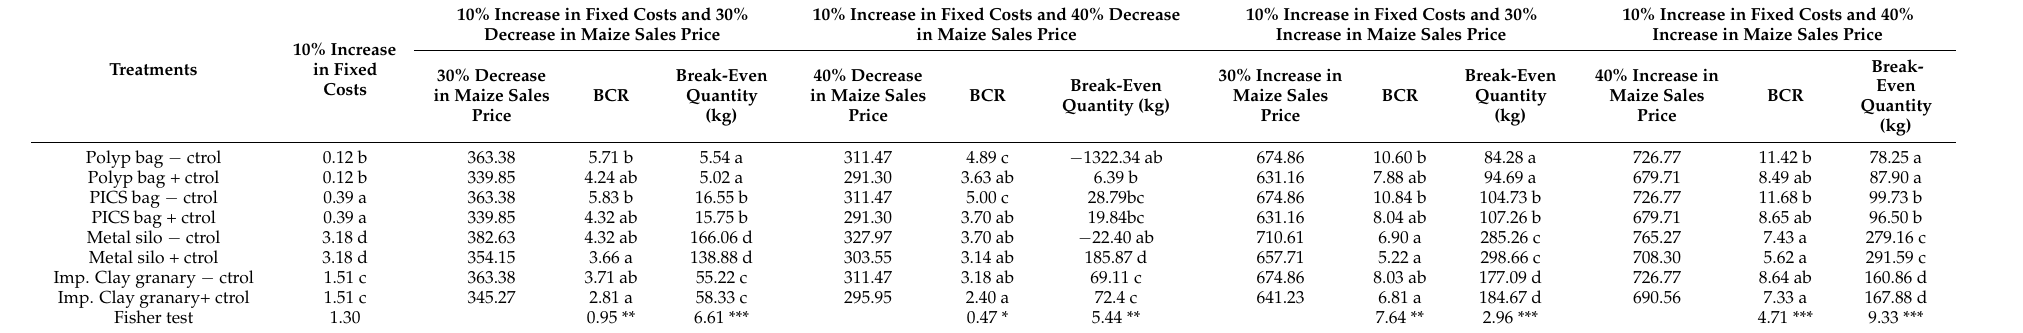
Table 5. Sensitivity analysis of the benefit–cost ratio and the break-even quantity of the different treatments implemented in Savalou.